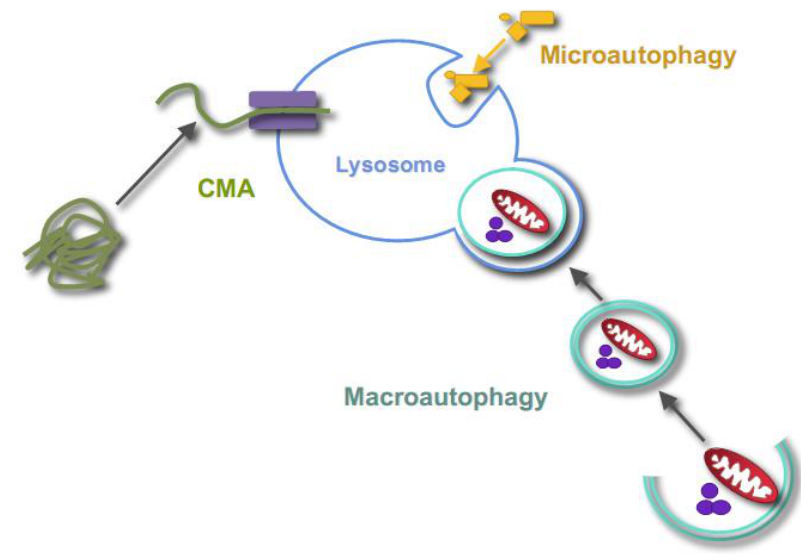
Figure 1. Different forms of